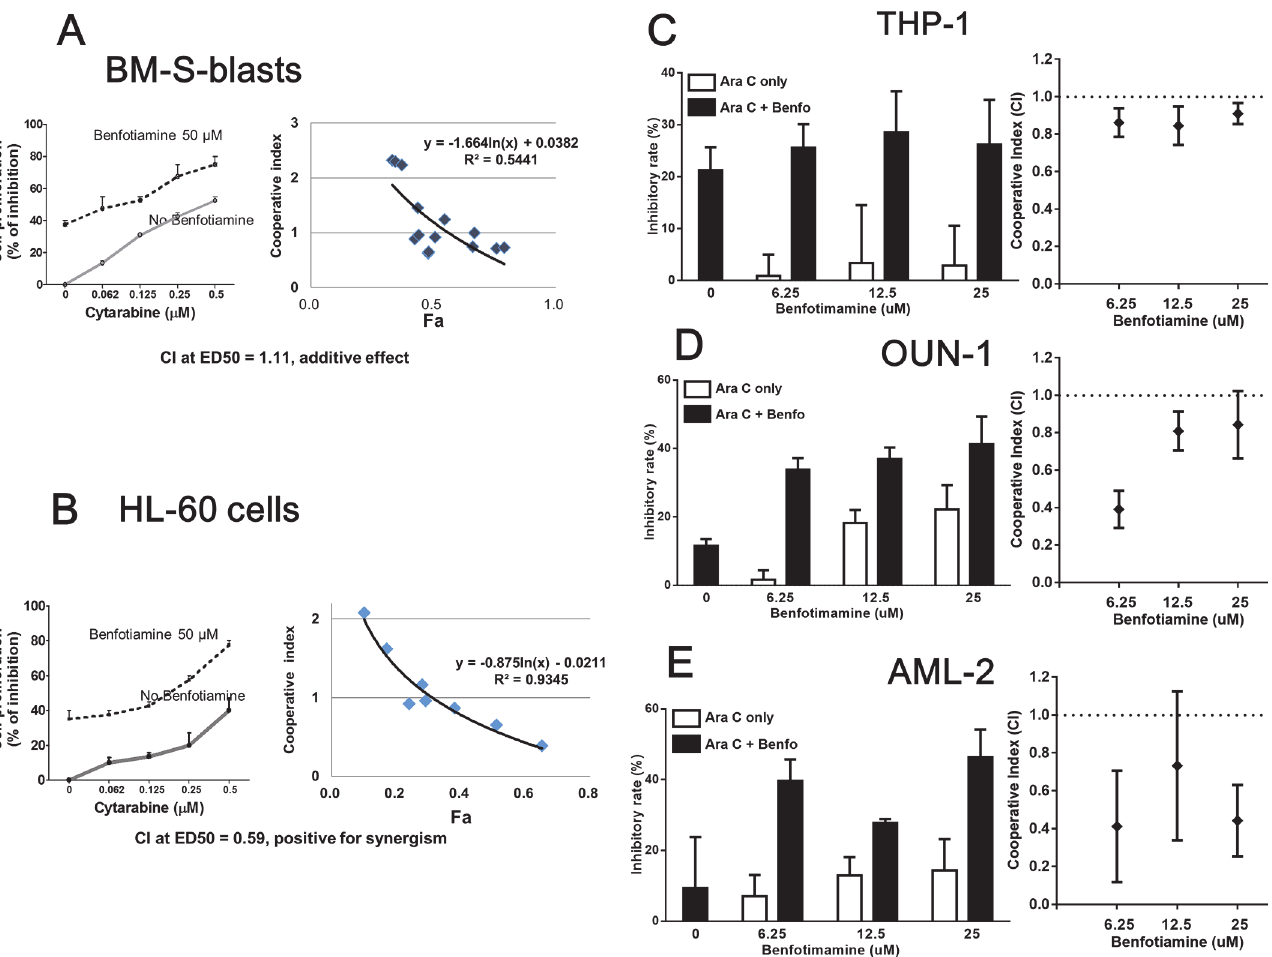
Fig 6. Benfotiamine acts synergistically with cytarabine to inhibit leukemia cell proliferation. BM-S blasts (A) and HL-60 cells (B) were cultured for 72 hours with various concentrations of cytarabine (Ara-C) alone or in combination with benfotiamine (50 μ M) and the degree of cell viability was assessed using an MTT assay. THP-1 cells (C), OUN-1 cells (D) and AML-2 blasts (E) were cultured for 72 hours with Ara-C alone (THP-1, 10 nM; OUN-1 and AML-2, 50 nM) or in combination with the indicated doses of benfotiamine and the degree of cell viability was assessed using an MTT assay. The combination index (CI) was calculated to determine drug interactions using the CompuSyn software